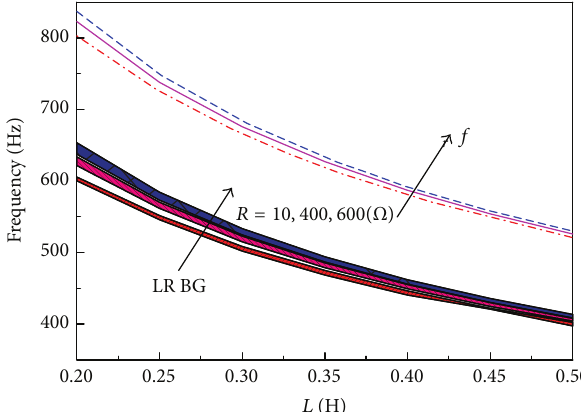
Figure 7: Distribution of the LR band gap of the two-dimensional PPC-C versus the inductance for different